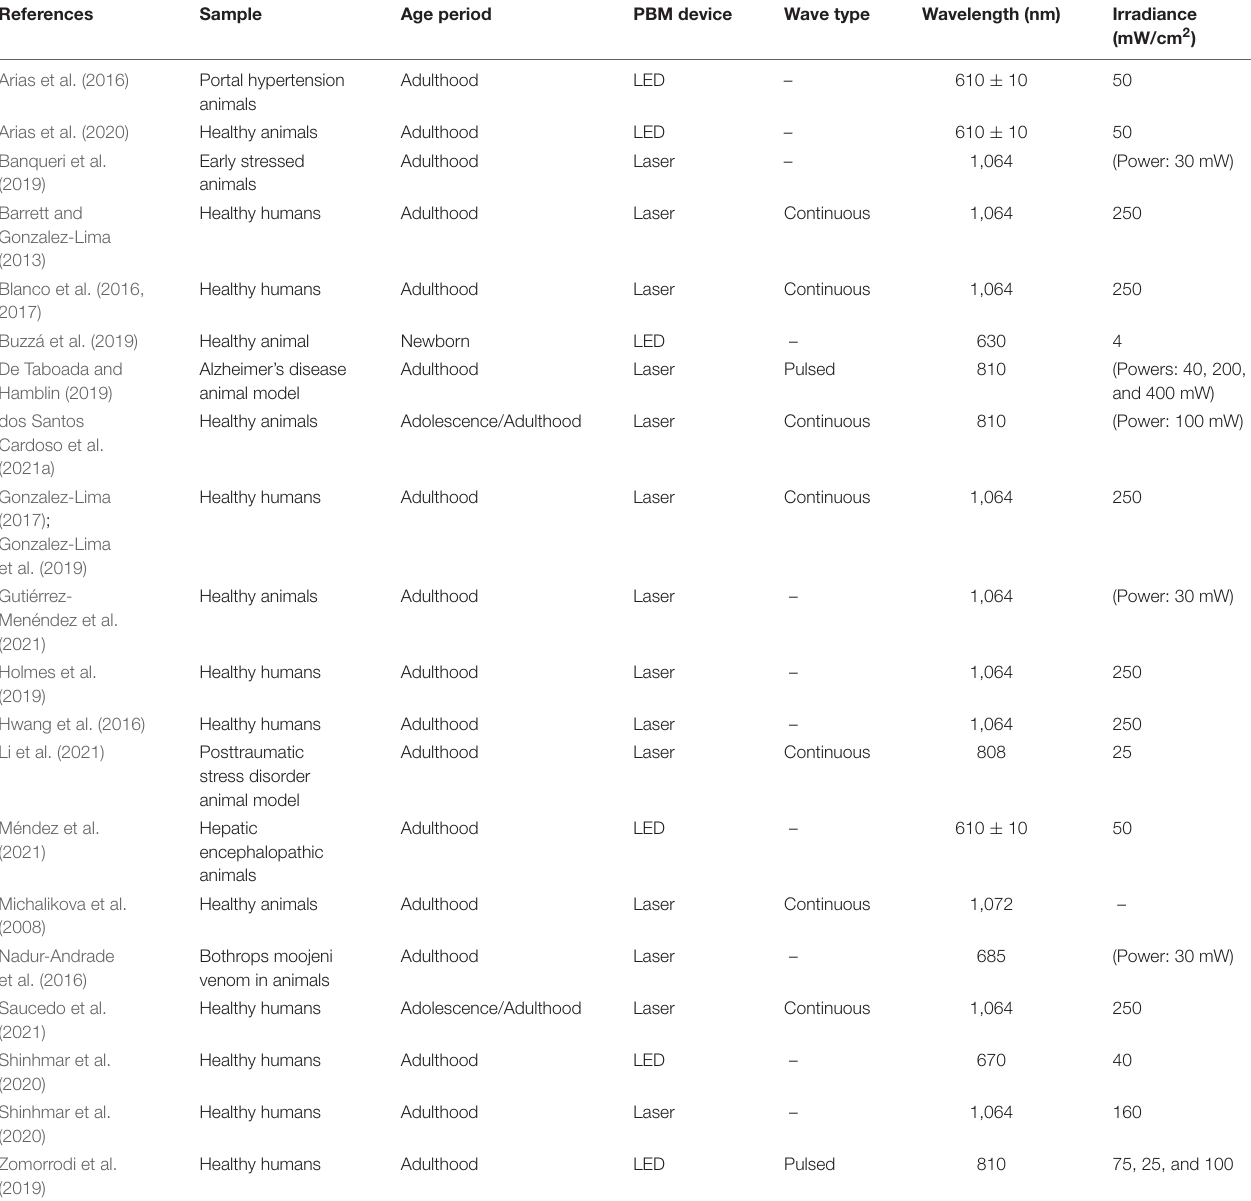
TABLE 1 | Comparison of PBM parameters used in previous